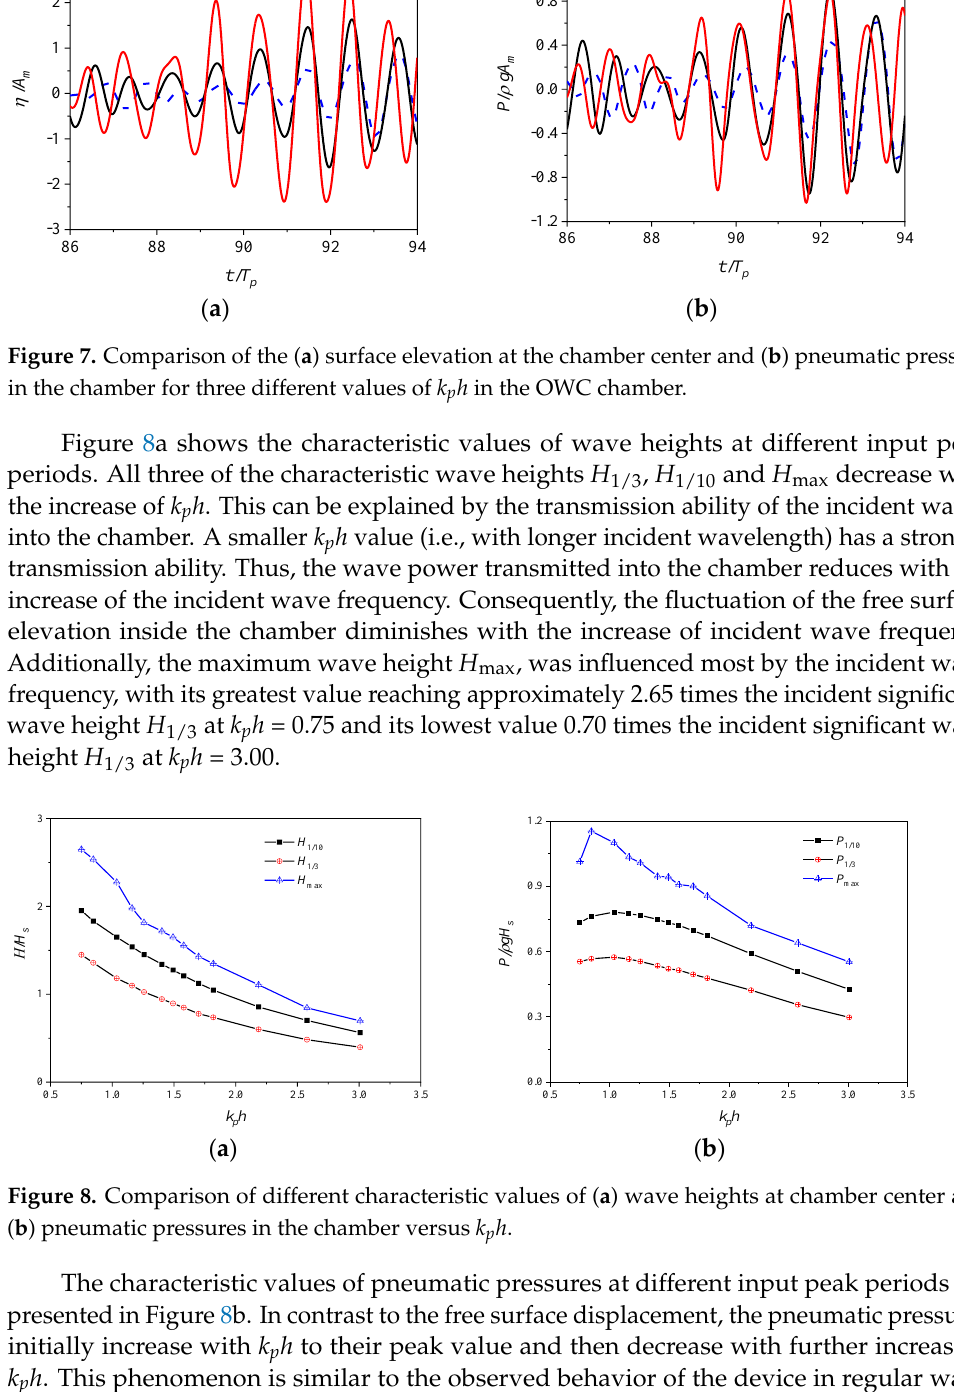
Figure 7. Comparison of the ( a ) surface elevation at the chamber center and ( b ) pneumatic pressure in the chamber for three different values of k p h in the OWC chamber.